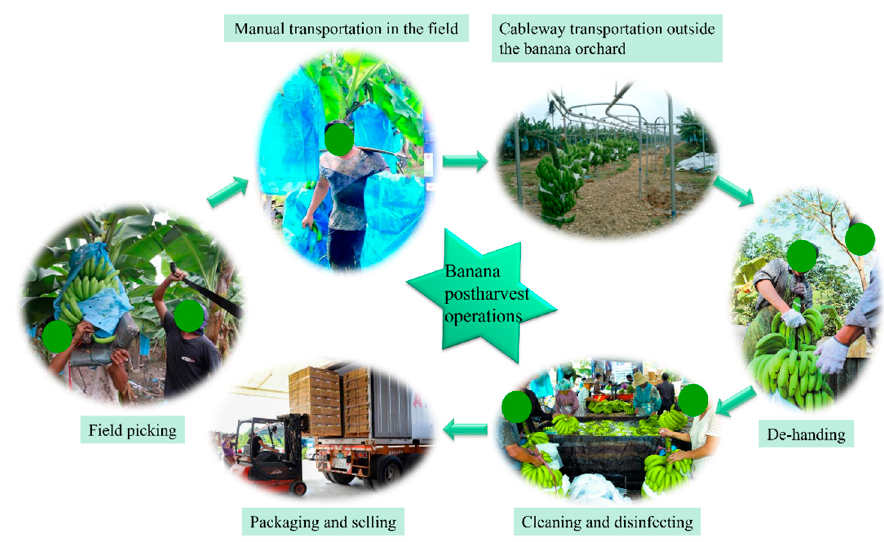
Figure 1. A general flow of banana harvest and postharvest operations.